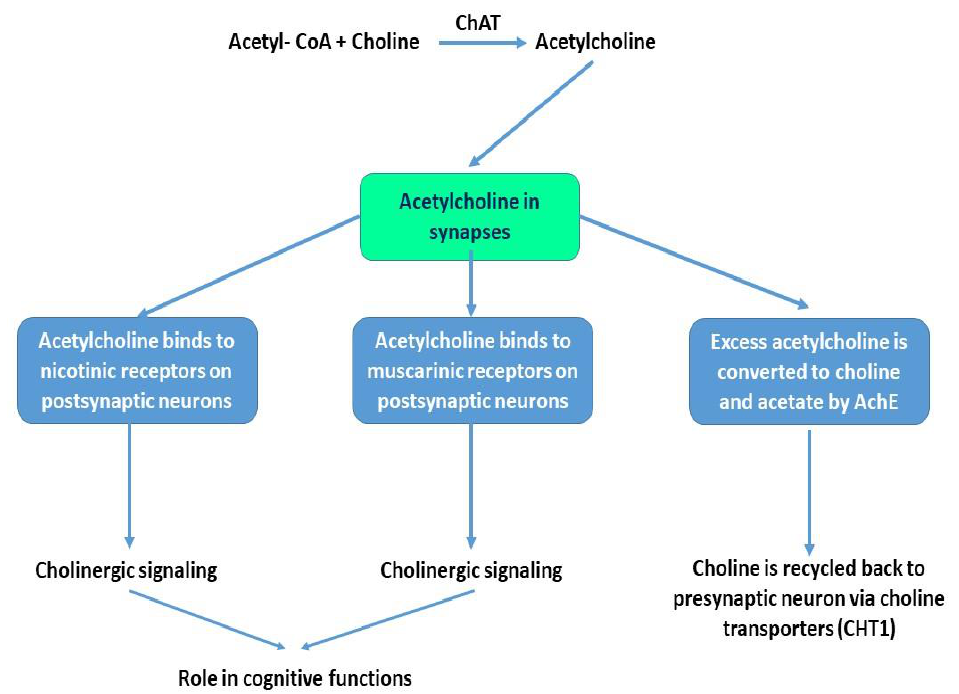
Figure 1. The role of acetylcholine at synapses. Choline is the main precursor for the formation of acetylcholine (Ach). Via the activity of choline acetyltransferase (ChAT), Ach is formed from choline and Acetyl-CoA. Once released at synapses, Ach binds to nicotinic or muscarinic receptors on postsynaptic neurons to regulate cholinergic signaling in different brain regions. Excess Ach at synapses is converted to choline and acetate via the activity of acetylcholine esterase (AchE). Choline is then recycled back to the presynaptic neuron via the presence of specific choline transporters such as CHT1. Where are these cholinergic neurons located in the human brain? The origin of ChAT-expressing neurons was identified as the nucleus basalis of Meynert (NBM) in the basal forebrain [23] with significant loss of these neurons in AD brain suggesting a correlation between the cholinergic system, Ach, NBM and the pathogenesis of AD [18]. Cholinergic neurons of the basal forebrain provide cholinergic innervation to cortical and limbic regions. For example, they send axonal projections to the hippocampus, amygdala and the neocortex [24]. The loss of these basal forebrain cholinergic neurons or their dysfunction has been linked to a decrease in ChAT activity, decrease in Ach release in specific brain regions such as in the hippocampus and cortical areas and to AD-related cognitive dysfunctions